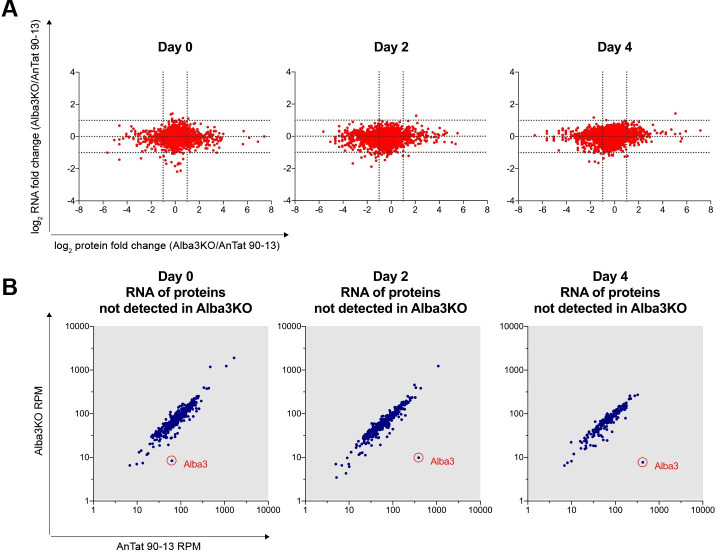
Differences in proteomes do not reflect the transcriptomes.(A) Comparison of the log2-fold changes between the proteomes and transcriptomes of AnTat 90–13 and Alba3KO on days 0, 2 and 4 of differentiation. Transcriptome data were obtained from three biological replicates. The dotted lines indicate a fold change of ≥ 2. (B) Scatter plot comparing the transcript levels (RPM, reads per million) in AnTat 90–13 and Alba3KO of proteins that were not detected in Alba3KO.